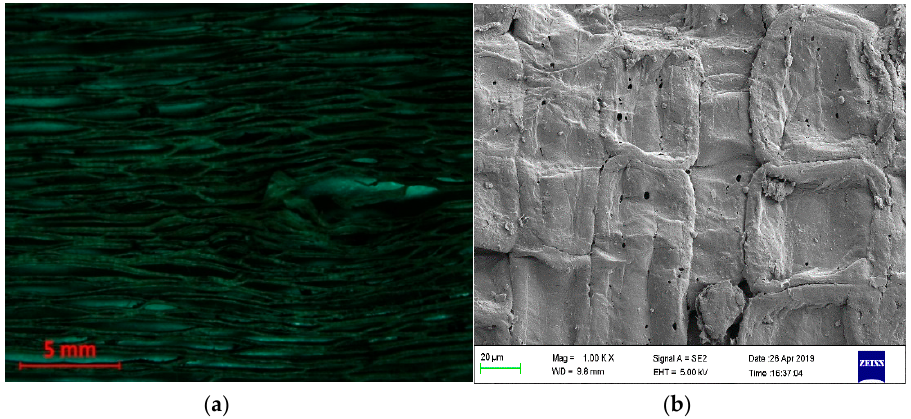
Figure 5. ( a , b ) Optical and SEM representation of treated linearly structured pawpaw fiber.